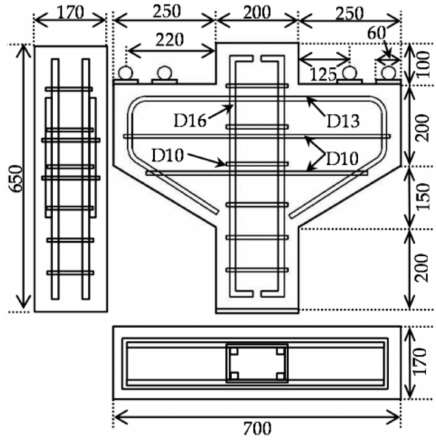
Figure 2. Specimen dimension and rebar details (units: mm).